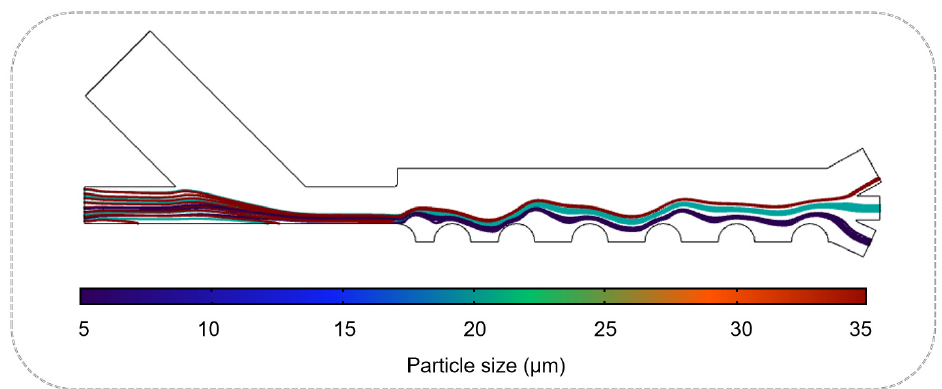
Figure A11. The dependence of different sized PS particle trajectories and final outlet positions on their initial injection positions: U 0 = 152 V eff , f = 100 kHz, σ m =0.001 S/m, u 1 = 2.5 mm/s, u 2 = 1.5 mm/s.